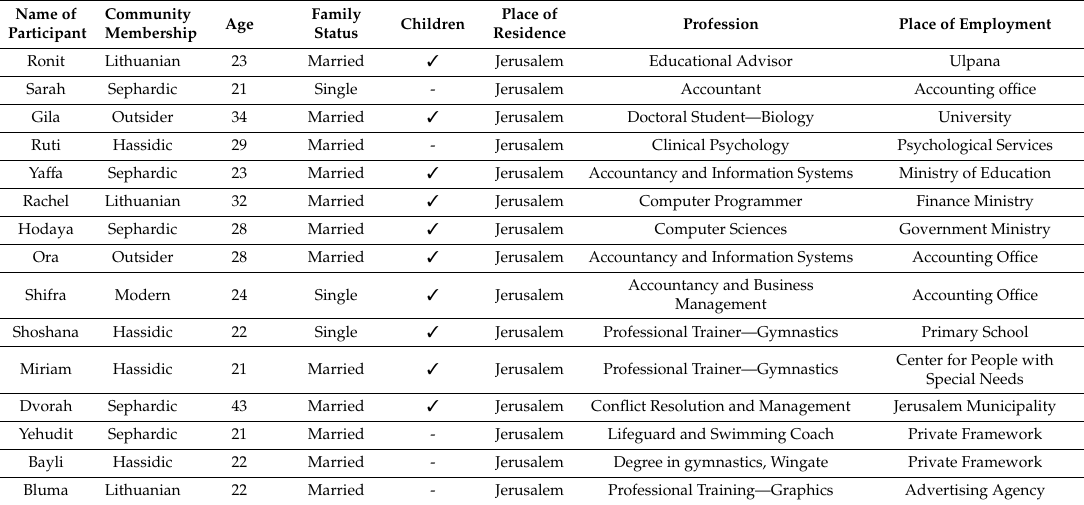
Table 1. Participants in focus group for women—personal